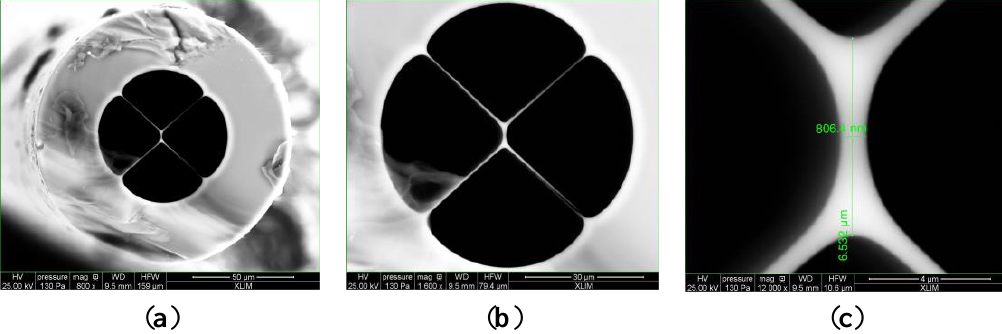
Figure 1. Microscope photograph of the microstructured optical fiber(MOF)’s cross section ( a ) with 800× amplification; ( b ) 1600× amplification; ( c ) core detail with 12,000×